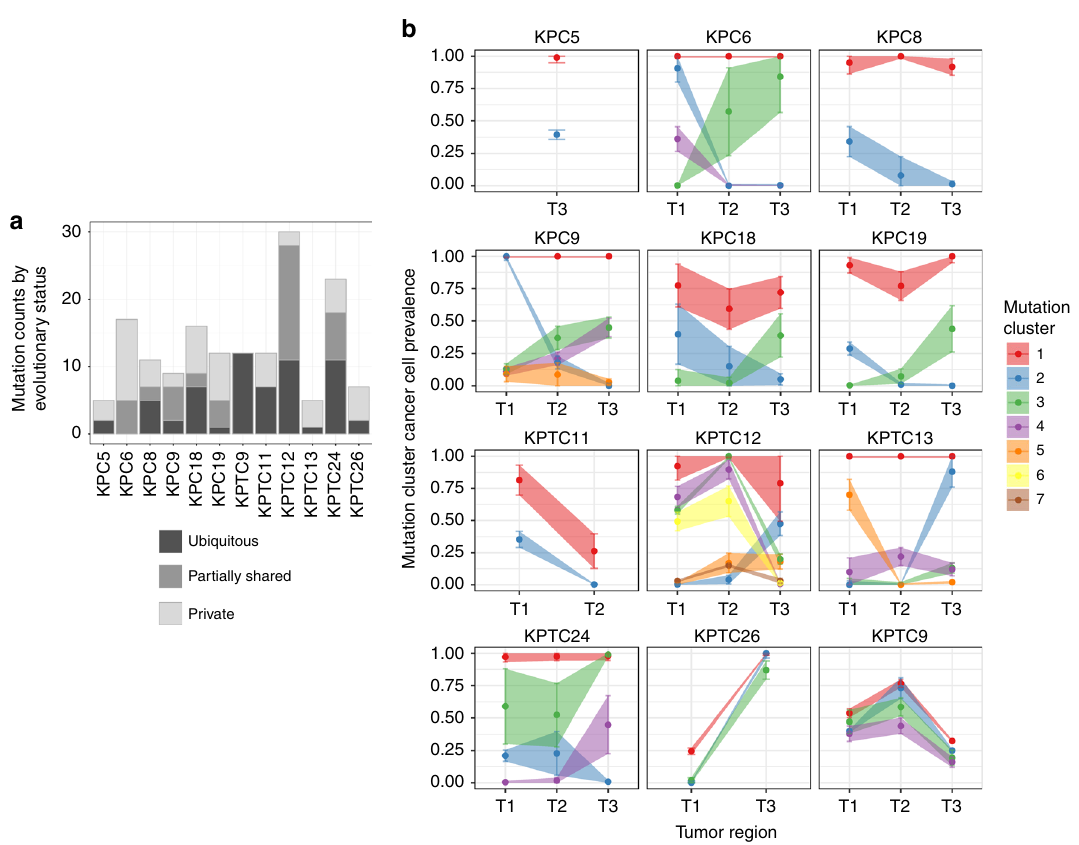
Fig. 3 Spatial heterogeneity of somatic mutations across tumor regions. a Evolutionary status of somatic mutations in each mouse PDA. Ubiquitous mutations were detected in all analyzed tumor samples of each mouse. Partially shared mutations were present in more than one, but not all, tumor samples. Private mutations were unique to one of the three tumor samples. b Mutation cluster cancer cell prevalence distributions across tumor regions. Error bars represent one standard deviation above and below the mean cluster cancer cell prevalence. The prevalence of mutations in each tumor region was estimated by utilizing allele speci fi c read counts from targeted sequencing, somatic copy number, and tumor purity. Mutations were grouped into distinct clusters of similar cancer cell prevalence across tumor regions. Tumor regions T1 and T2 from KPC5 , T3 from KPTC11 , and T2 from KPTC26 were excluded from analysis, due to low variant allele frequency ( ≦ 0.02) of all mutations, or insuf fi cient DNA to perform array-CGH ( KPTC26